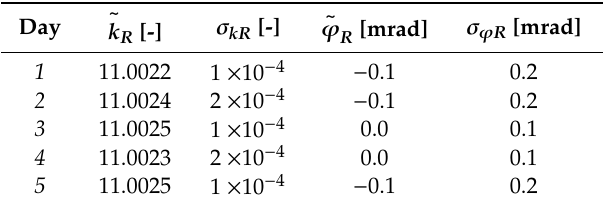
Figure 3. Simple representation of the setup adopted to characterise the resistive divider. Table 3. Actual ratio and phase displacement of the R-divider + DAQ measurement chain, together with their standard deviations when 57 V are applied.